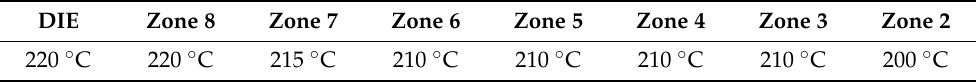
Table 1. Temperature zones